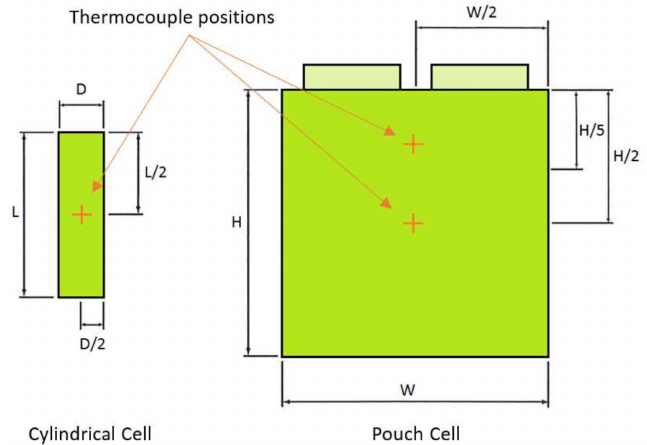
Figure 2. Cell temperature measurement locations for both the 18,650 cells and the pouch